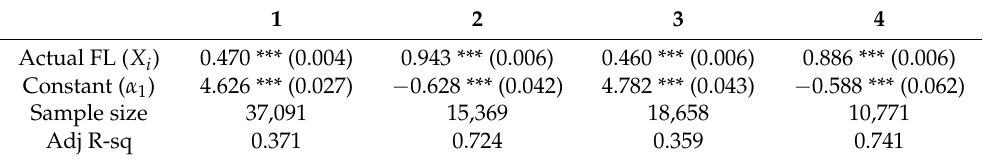
Table 2. Determinants of self-perceived financial literacy (regression results for Equation (1)).